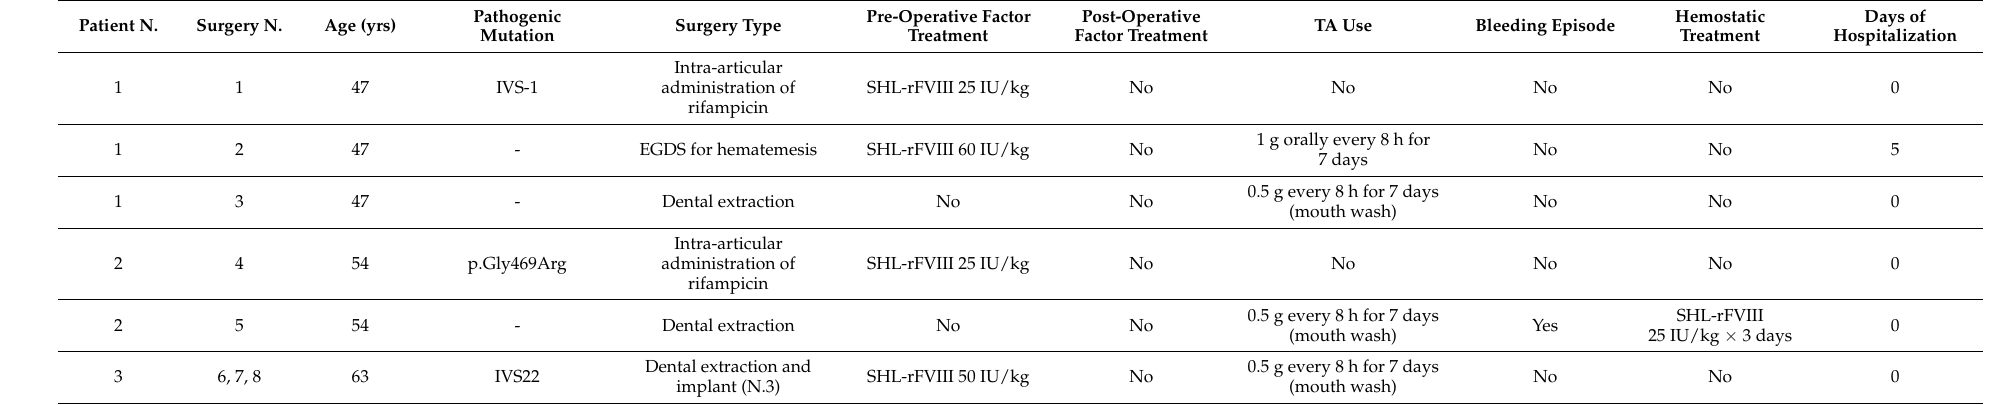
Table 4. Minor surgeries in patients without